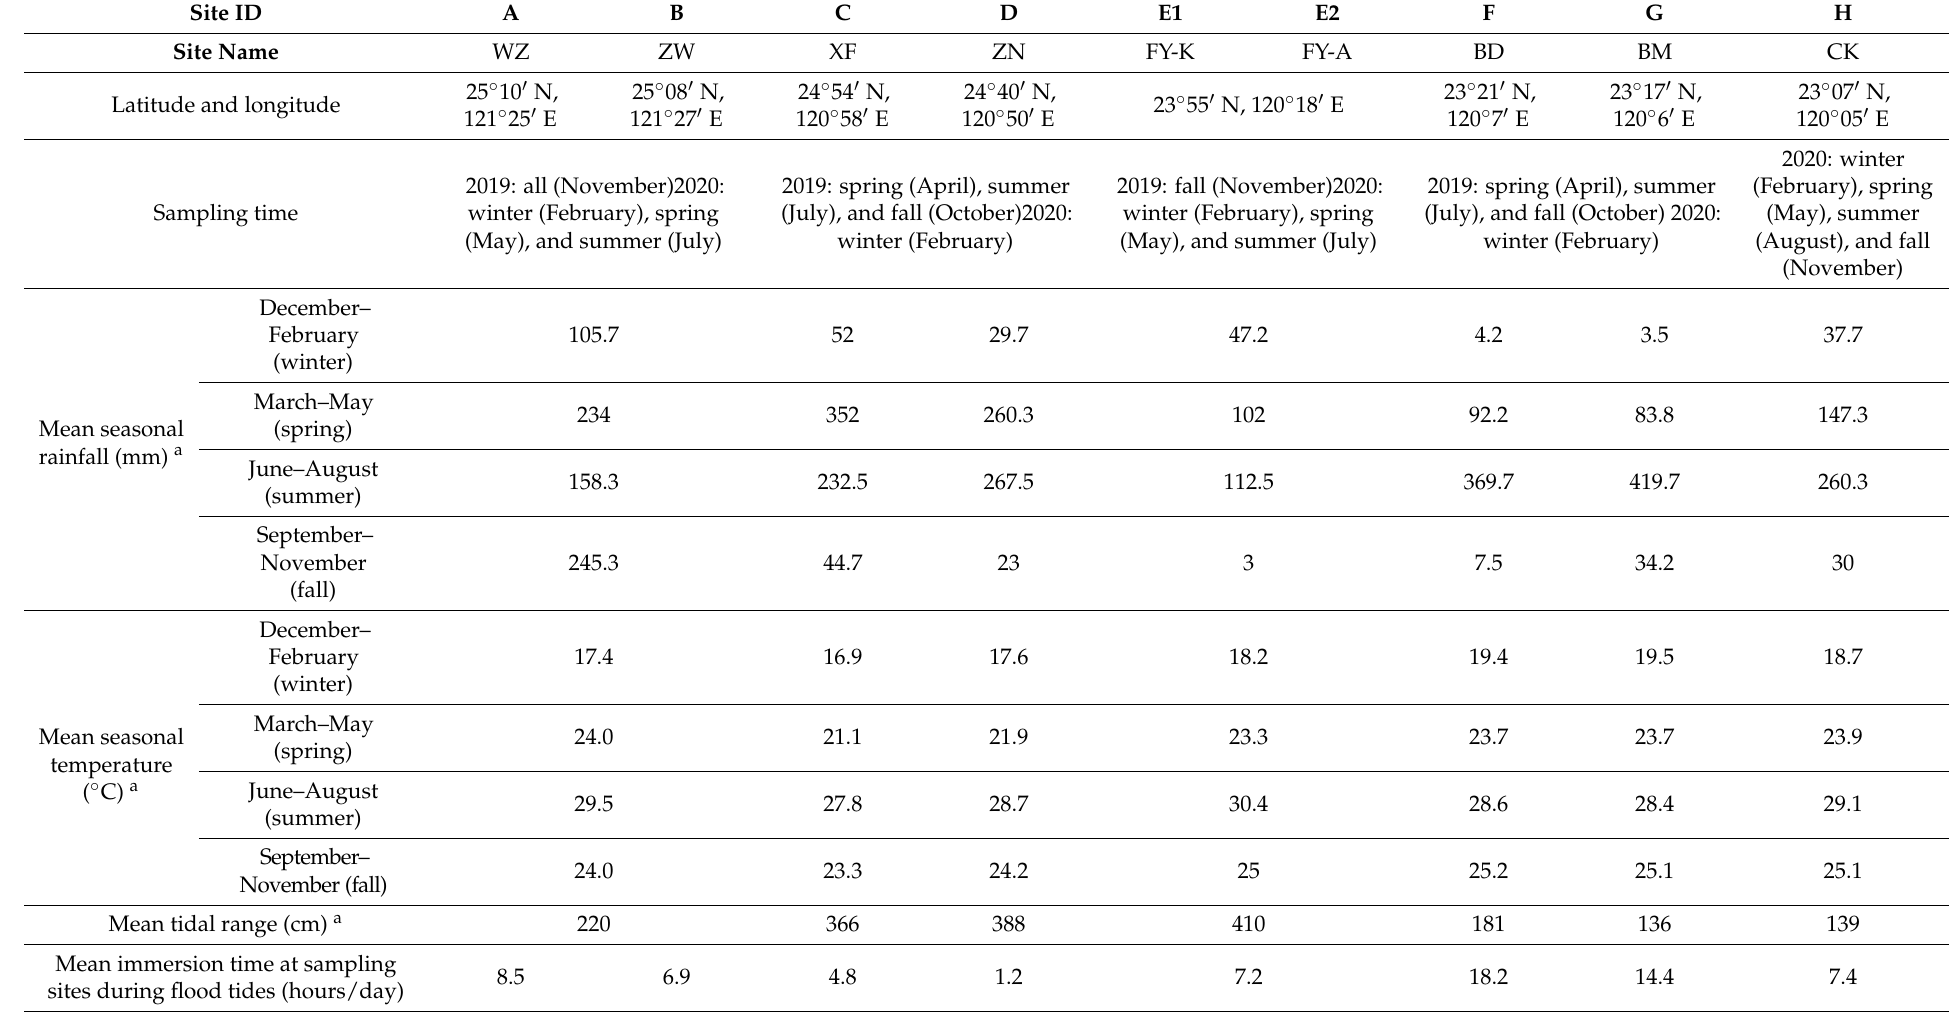
Table 1. Climatic conditions, mangrove characteristics and soil texture at the mangrove sites: A—Wazihwei (WZ); B—Zhuwei (ZW); C—Xinfeng (XF); D—Zhunan (ZN); E1—Fangyuan Kandelia obovata (FY-K); E2—Fangyuan Avicennia marina (FY-A); F—Budai (BD); G—Beimen (BM); H—Chiku